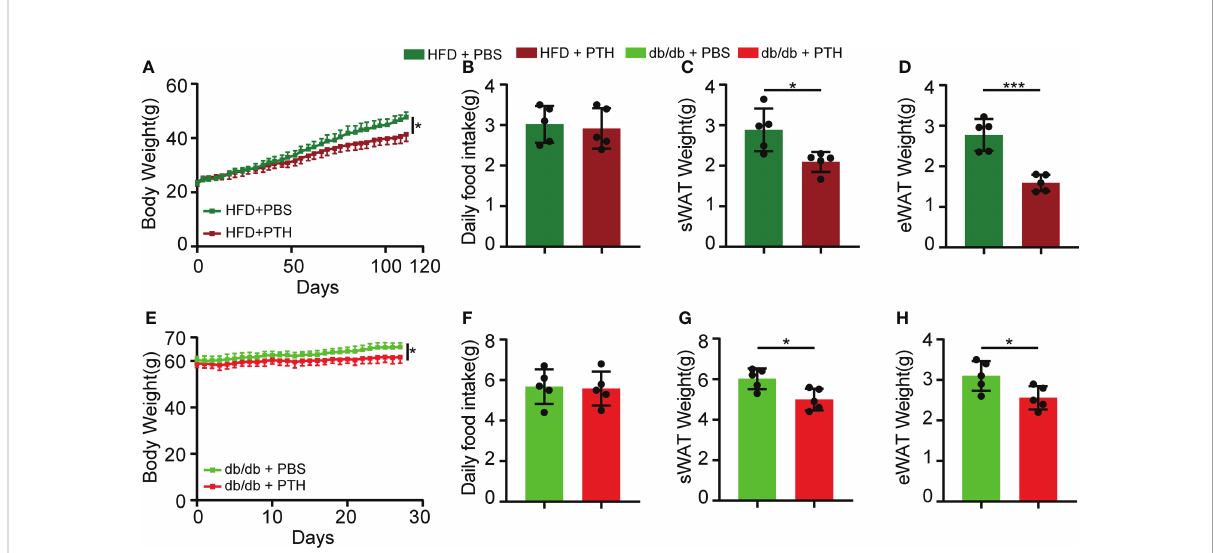
FIGURE 1 Intermittent administration of PTH reduced body weight and fat mass in DIO mice and db/db mice. (A – D) Eight-week-old C57/BL6 male mice were fed on a high-fat diet (HFD) for 16 weeks. During the period of HFD feeding, the mice were subcutaneously injected with PTH (40 m g/kg daily) or PBS. (A) Body weight curve. (B) Daily food intake. (C, D) The weights of sWAT and eWAT in DIO mice. (E – H) Twenty-week-old male db/db mice were subcutaneously injected with PTH (40 m g/kg daily) or PBS for 1 month. (E) Body weight curve. (F) Daily food intake. (G, H) The weights of sWAT and eWAT in db/db mice. Data are shown as mean ± SD (n=5/group). *p < 0.05; ***p < 0.001 by two-tailed Student ’ s t-test or two-way